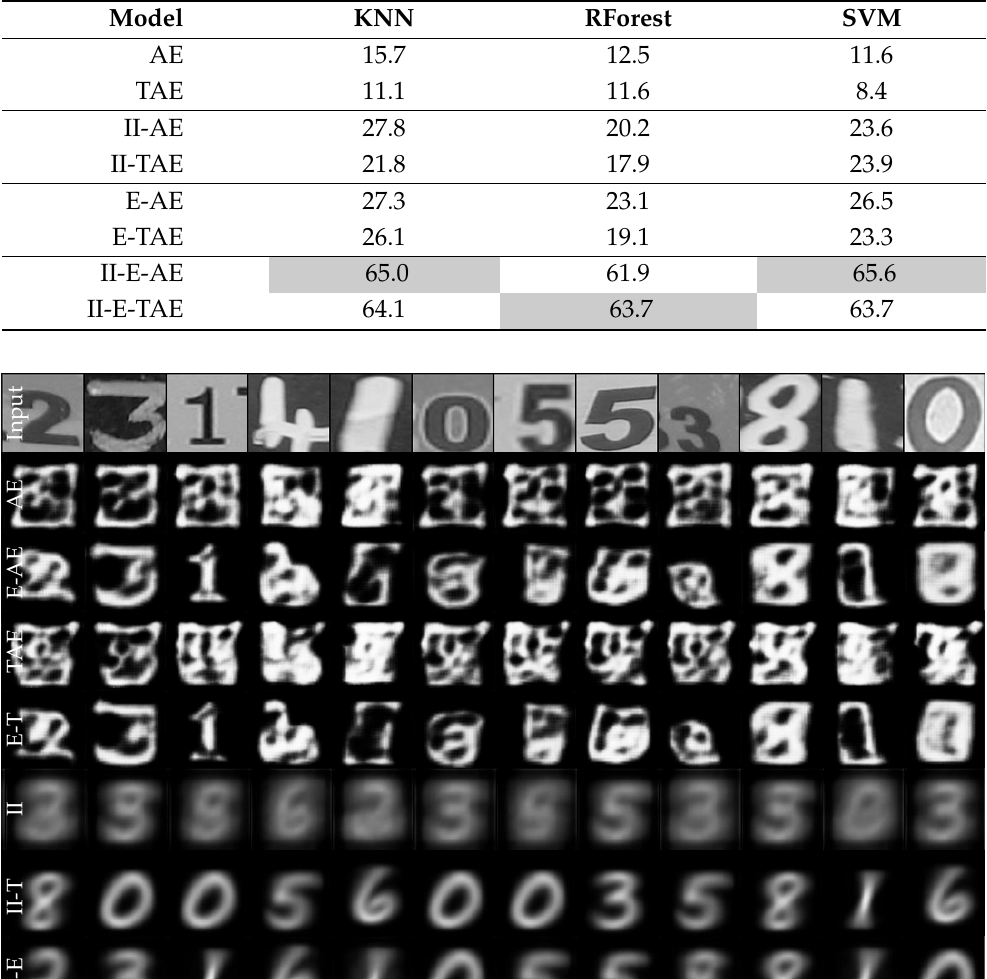
Table 5. Different model variations trained on MNIST. The classifiers were trained on the training data latent space and evaluated on real digits: k-nearest neighbour (KNN), random forest (RForest) and support vector machine with a linear kernel (SVM). We used the triplet loss (TAE), the first (I) or the second variation (II) of the PIRL and the extractor module (E).